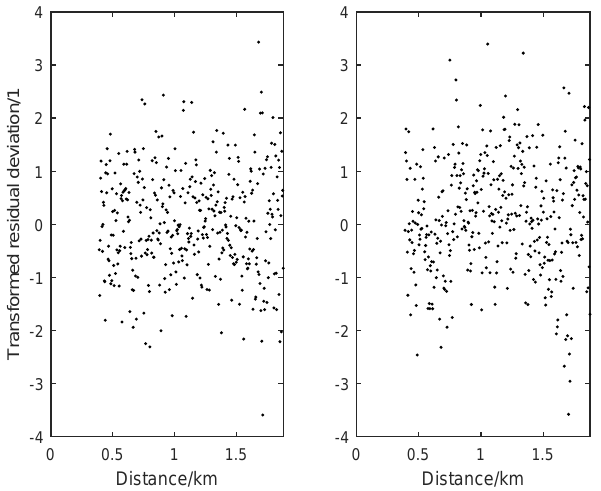
Figure 14. As Fig. 10 but for the results of the GLS approach shown in Fig.